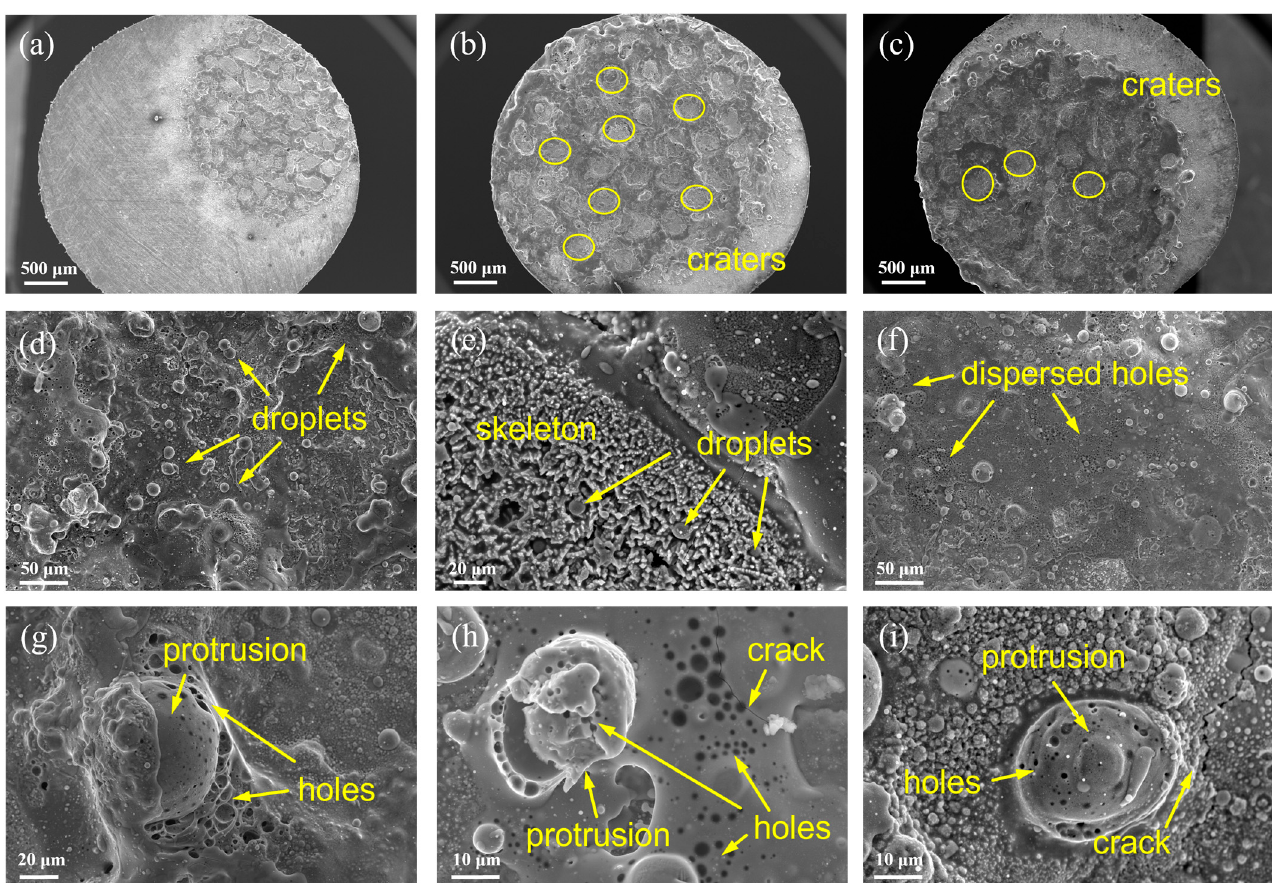
Figure 3. SEM images of electric contact materials after arc erosion: ( a ) Al 2 O 3 -Cu/25Mo5Ta anode at 10 A; ( b ) Al 2 O 3 -Cu/25Mo5Ta anode at 30 A; ( c ) 0.5Y 2 O 3 /Al 2 O 3 -Cu/25Mo5Ta anode at 30 A; ( d ) Al 2 O 3 - Cu/25Mo5Ta anode at 10 A; ( e ) Al 2 O 3 -Cu/25Mo5Ta cathode at 10 A; ( f ) Al 2 O 3 -Cu/25Mo5Ta anode at 30 A; ( g – i ) 0.5Y 2 O 3 /Al 2 O 3 -Cu/25Mo5Ta cathode at 30 A.